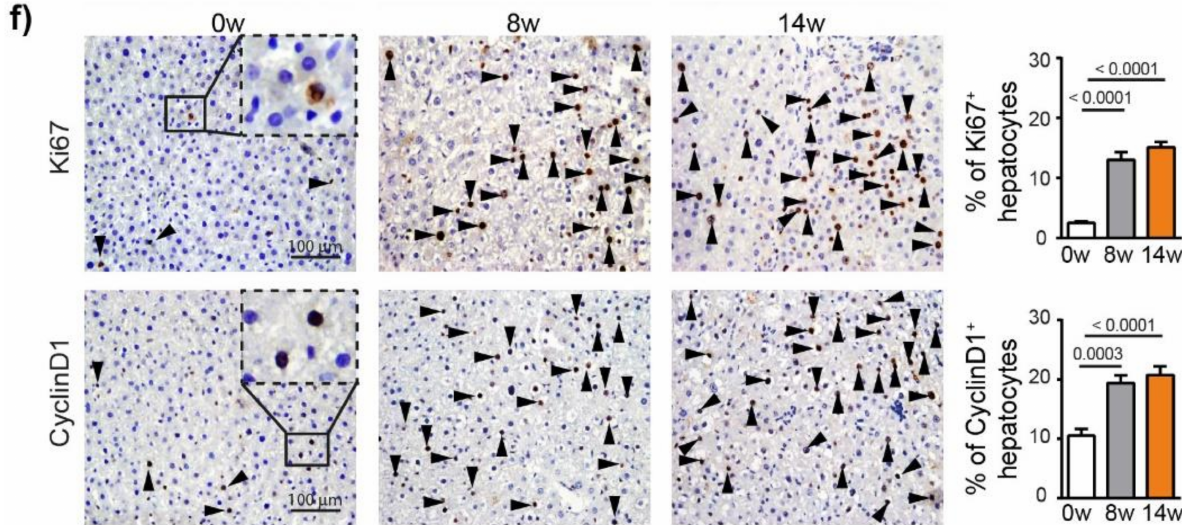
Figure 1. Chronic DEN-induced hepatocarcinogenesis is associated with high hepatocyte proliferation. ( a ) Timeline protocol to characterize DEN-induced cirrhotic rat model of HCC. Seven-week-old Fisher 344 rats were injected weekly by DEN (50 mg/kg per week). The term 0 w indicates the baseline before DEN injections, 8 w indicates 8 weeks of DEN injections, 14 w indicates 14 weeks of DEN injections and 20 w indicates 14 weeks of DEN injections followed by 6 weeks of no DEN. ( b ) Representative pictures of rat liver at 0 w and 14 w. ( c ) Macroscopic examination of livers with assessment of tumor number at the surface of livers and tumor size (average of diameter of the five largest tumors). Each circle represents an individual animal, mean ± SE, n = 13/group. ( d ) Representative images of GST-P (4 × magnification) and quantification of GST-P+ surface area per high power field (HPF). Mean ± SE, n = 9/group. ( e ) Representative images of CD133 staining (4 × magnification) and quantification of CD133 + surface area per HPF. ( f ) Representative images of nuclear Ki67 and CyclinD1 staining (20 × magnification-black arrows) and quantification of nuclear Ki67 + and CyclinD1 + hepatocytes per HPF. Mean ± SE, n = 9/group. The comparison of means was performed using the ANOVA test with Tukey correction, w = weeks.